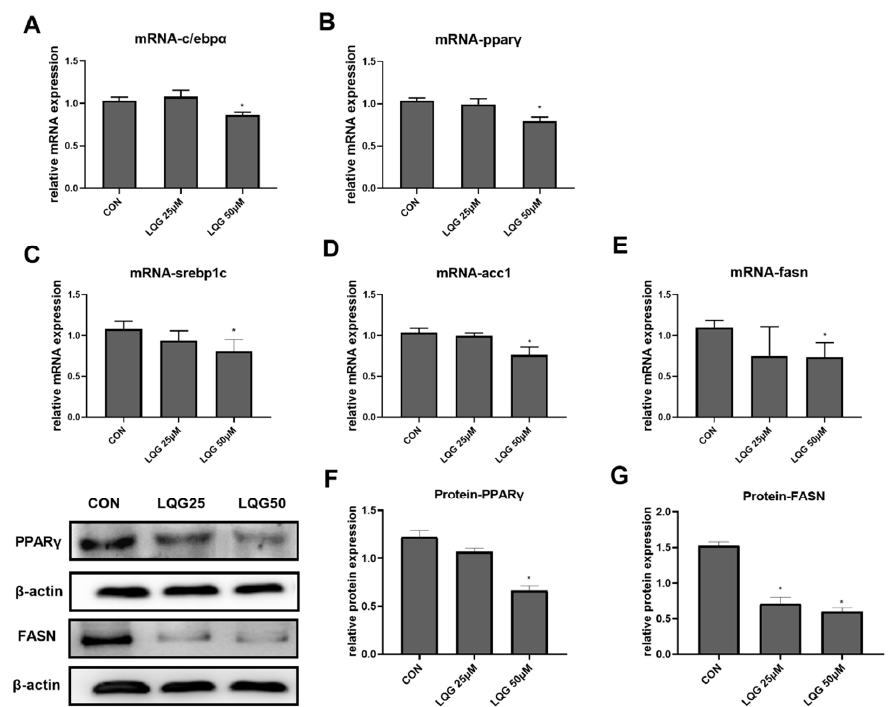
Figure 2. Effects of LQG on molecular regulators of lipid synthesis in 3T3-L1 adipocytes. The cells were treated with 25 and 50 µ M LQG. The mRNA-expression levels of ( A ) c/ebp α , ( B ) ppar γ , ( C ) srebp1c, ( D ) acc1, and ( E ) fasn were measured by RT-PCR, and the protein levels of ( F ) PPAR γ and ( G ) FASN were analyzed by Western blotting. Protein expression was quantified by densitometry, and the relative intensities are expressed in the bar charts. Values are presented as means ± SEMs ( n = 3) and analyzed with one-way ANOVA. * shows a statistically significant difference compared with control group ( p ≤